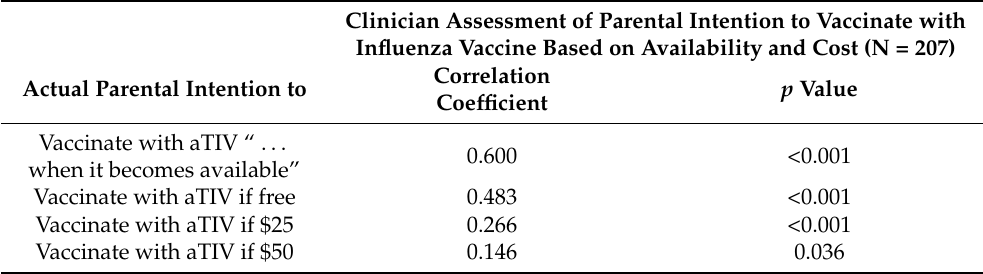
Table 2. Correlation between clinicians’ assessment of parents’ intentions to vaccinate with the adjuvanted seasonal flu vaccine and parents’ actual intentions to